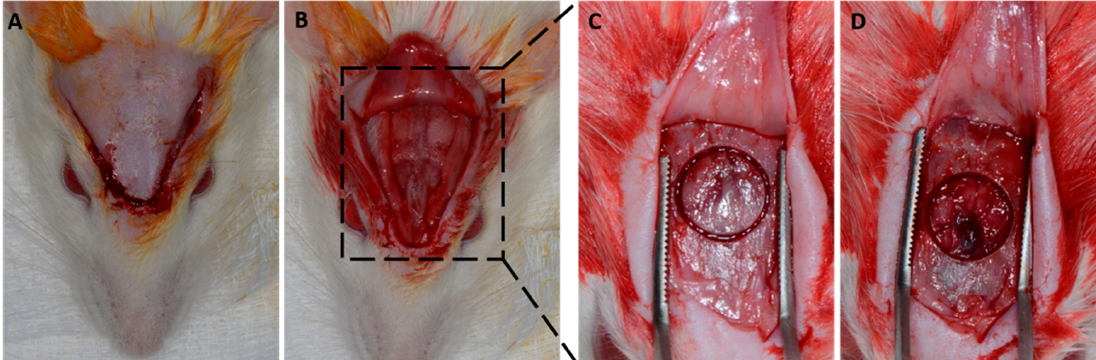
Figure 1. Experimental surgical procedure, performed after antisepsis in the region. ( A ) Trichotomy performed and V incision in the occiput-frontal direction; ( B ) exposed calvaria after total flap detachment; ( C ) marking of the 8 mm defect to be created; and ( D ) 8 mm critical defect performed while preserving the dura mater.